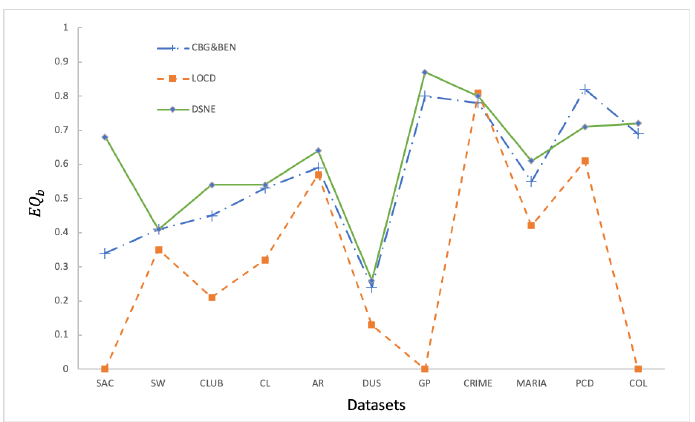
Figure 8. Experimental results of three algorithms evaluated by EQ b in 11